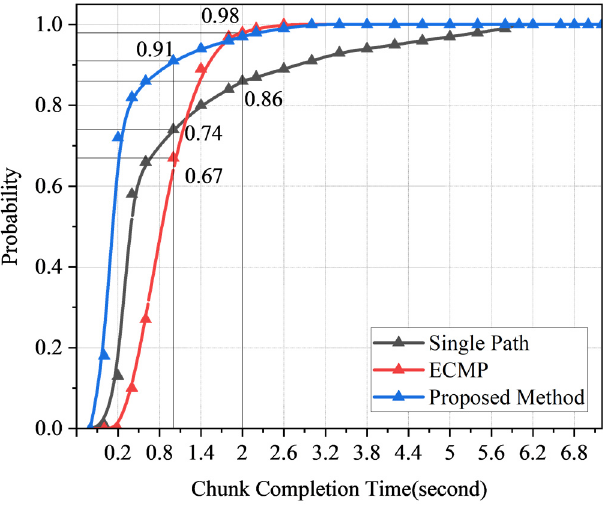
Figure 8. The cumulative distribution of the CCT.